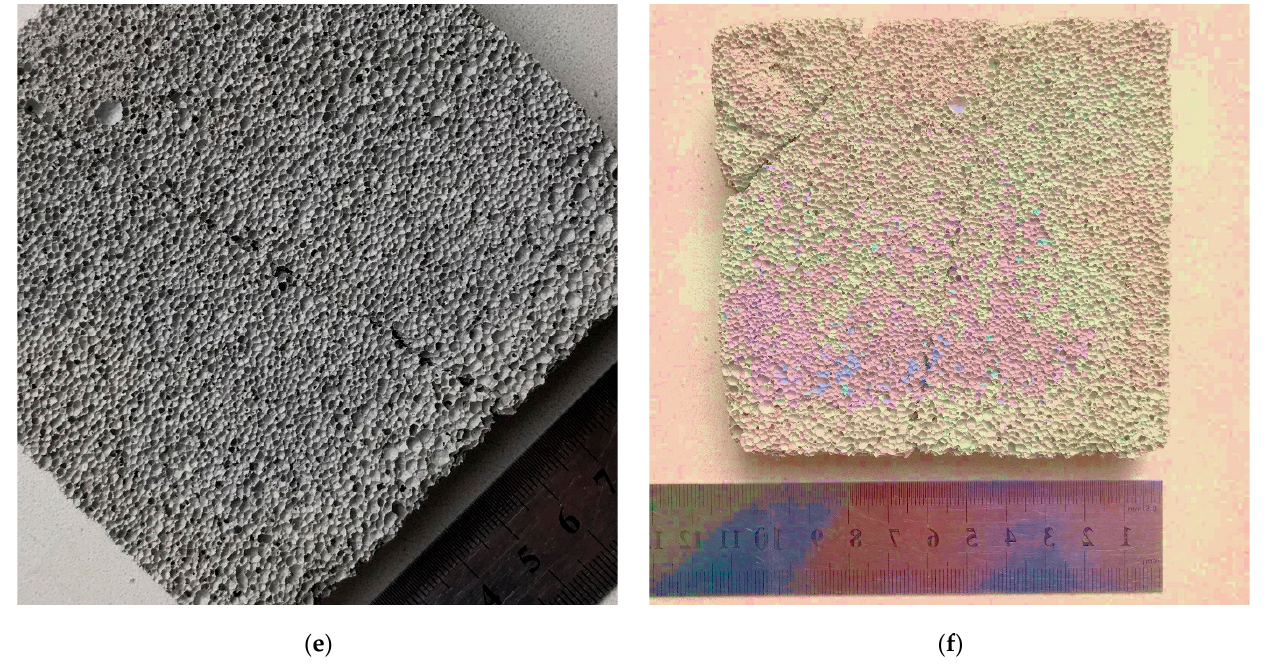
Figure 3. Image augmentation: ( a ) original image, ( b ) shift along the Ox and Oy axes, ( c ) vertical display, ( d ) horizontal display, ( e ) random rotation, and ( f ) change in brightness, contrast and saturation.